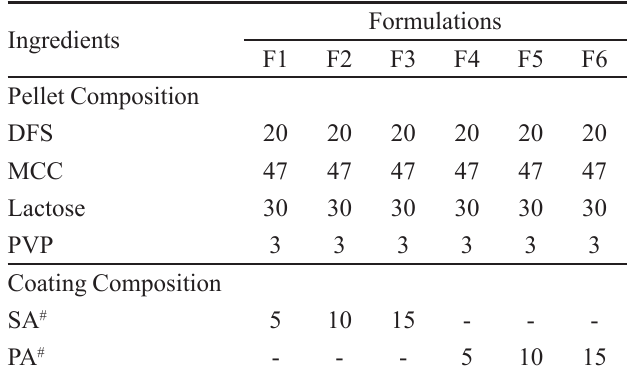
TABLE I - Formulations of SA and PA coated pellets. All quantities indicated in %w/w basis. DFS- Diclofenac